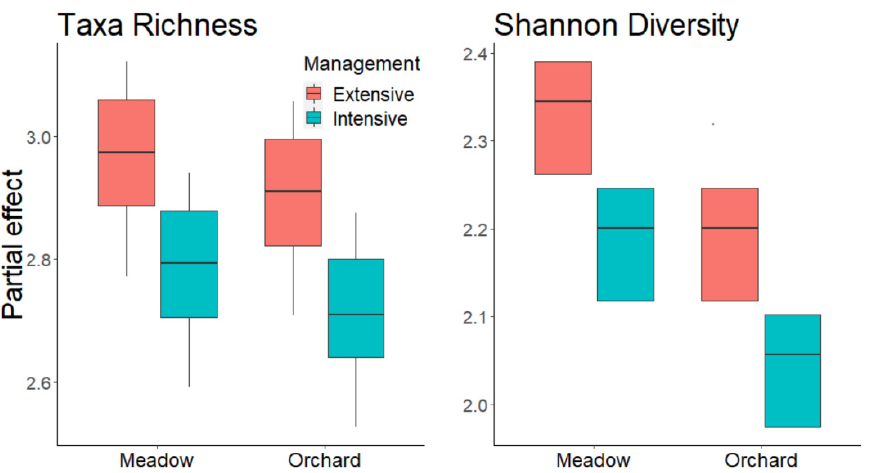
Figure 2. Boxplot of the partial effect of habitat (meadow and orchard) and management intensity (intensive and extensive) on taxa richness and diversity (Shannon diversity) ( n = 18). The data was extracted from the linear mixed model accounting for the effect of region and season treated as random factors. Boxplot depicting the interquartile range (IQR between the 25% and the 75%) and the median, whiskers extending 1.5 * the IQR.